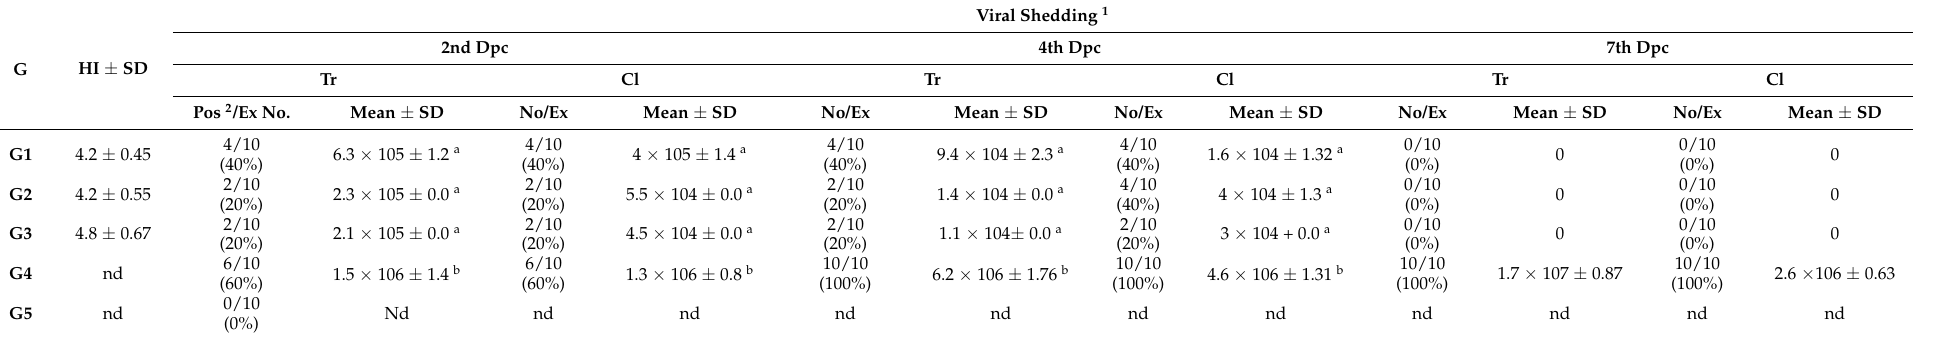
Table 4. Mean HI titers, mortality percentages, and viral shedding in vaccinated and non-vaccinated challenged groups on day 28 with VNDV genotype